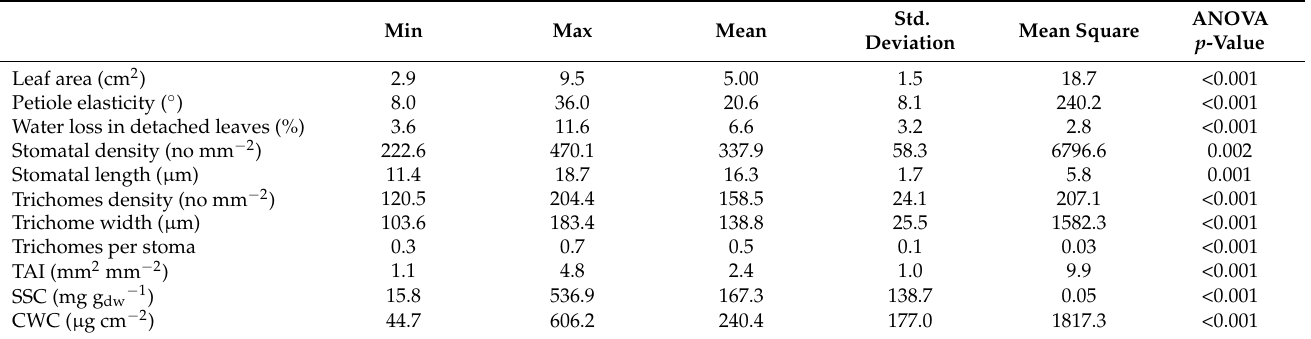
Table 2. Extreme values, means, and analysis of variance of the leaf traits of the 32 studied olive varieties. Min Max Mean